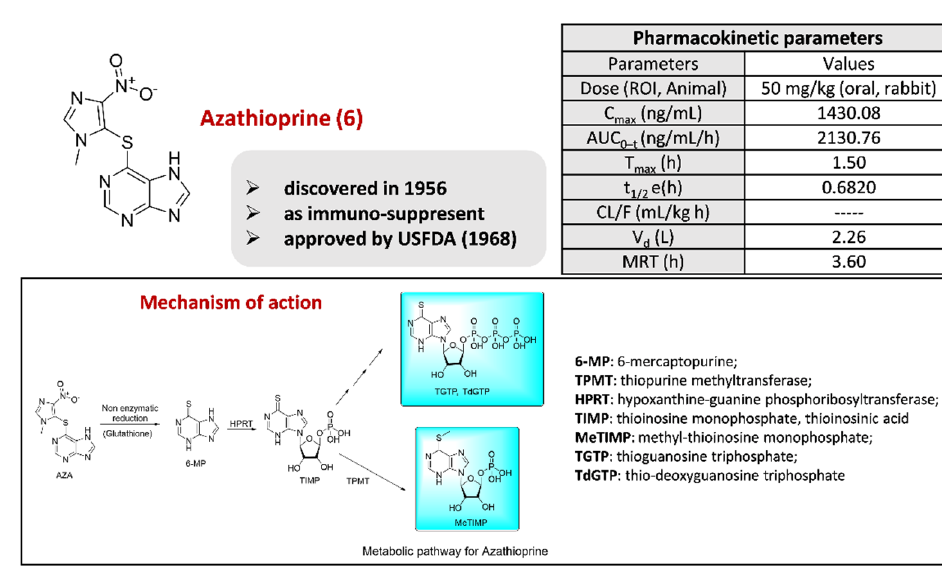
Figure 9. Activity profile of Azathioprine 6